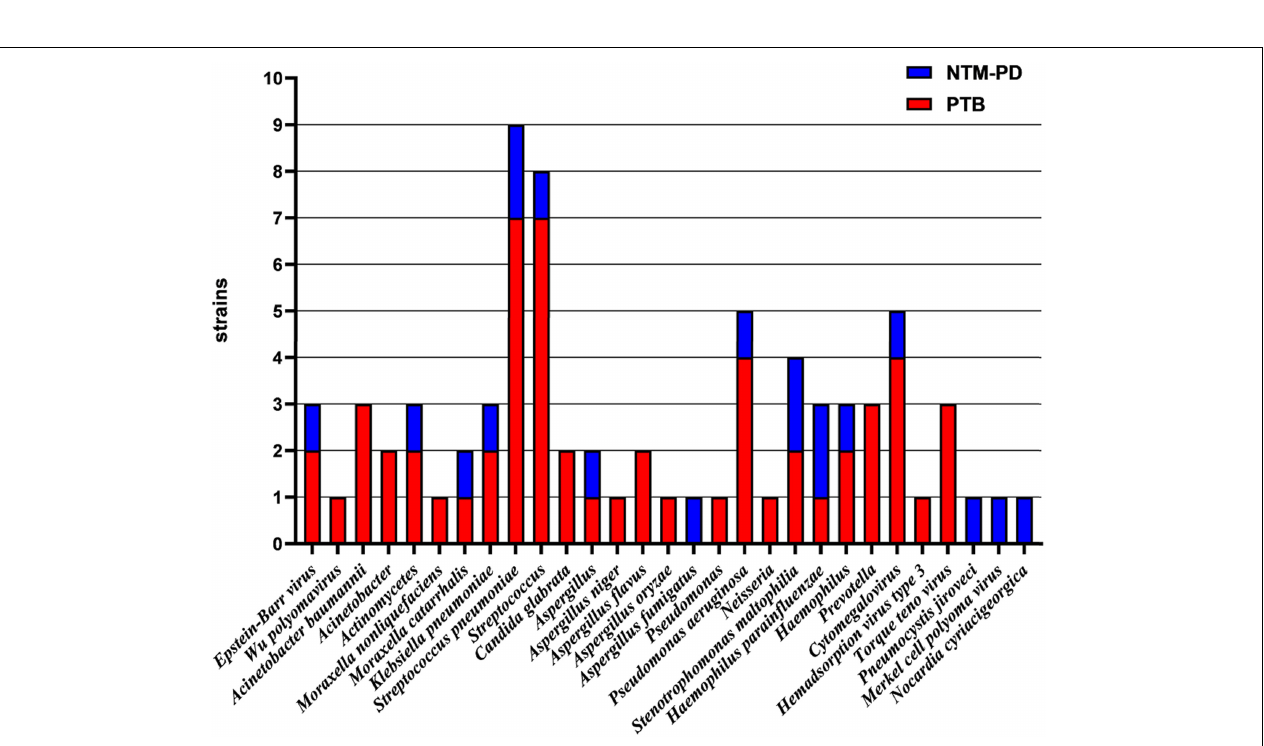
FIGURE 5 | Identification of strains in BALF samples from patients with PTB and NTM-PD complicated with co-infection using mNGS.